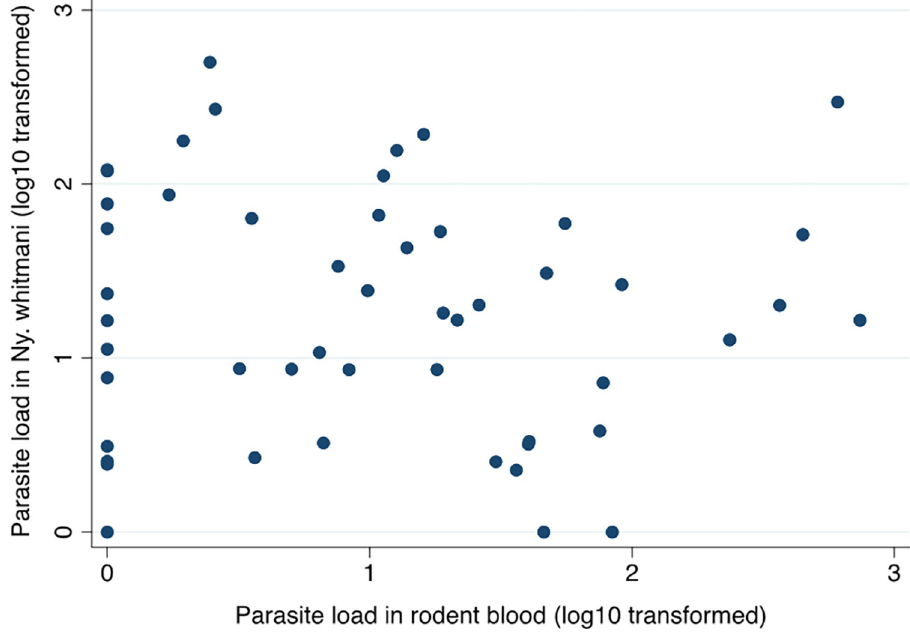
Fig 4. The association between the log 10 transformed L . ( V .) braziliensis parasite loads estimated by qPCR in rodent blood samples and in Ny . whitmani sand flies infected during xenodiagnosis.